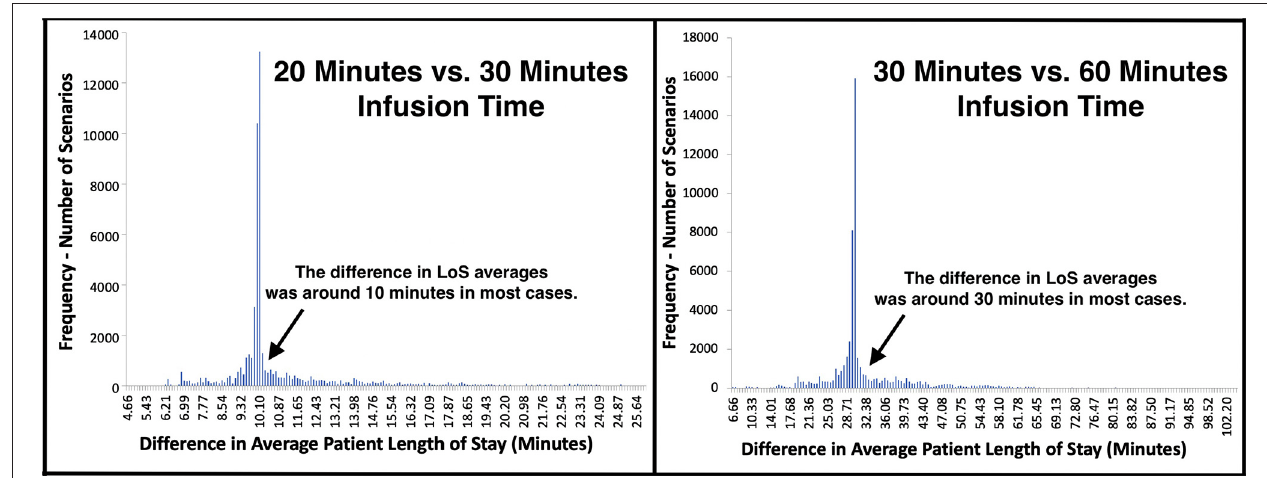
FIGURE 4 | Distribution of LoS difference when different infusion times were compared.